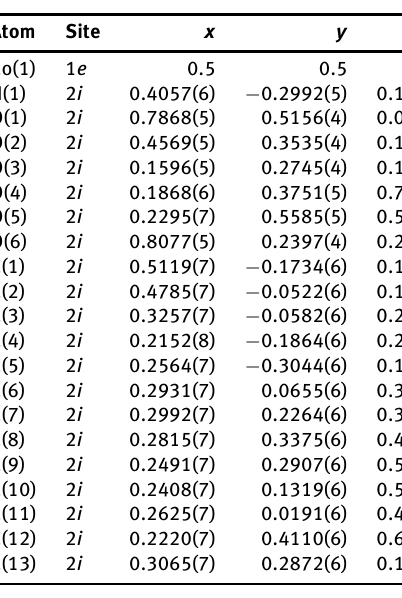
Table 3: Atomic displacement parameters (Å 2